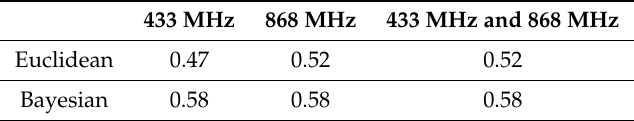
Table 16. Overview of total identification accuracy rates for the entire experimental